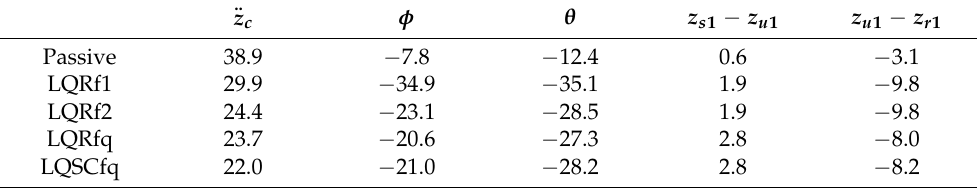
Table 5. Magnitudes of frequency responses for each controller (dB